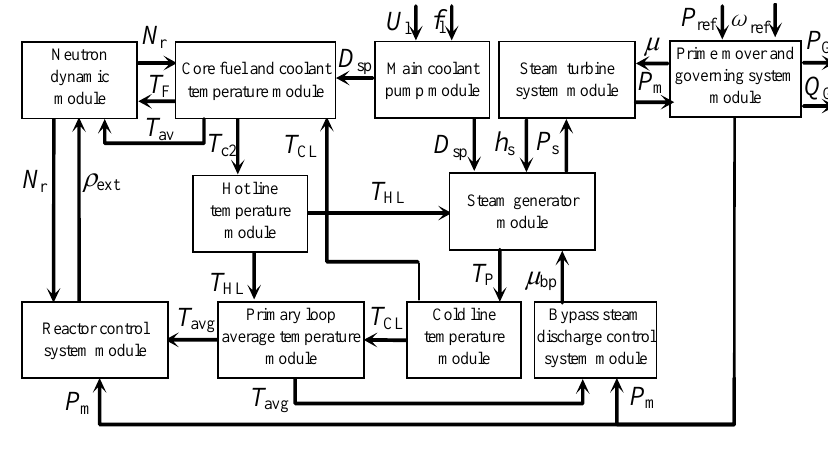
Figure 1. AP1000 system model diagram.